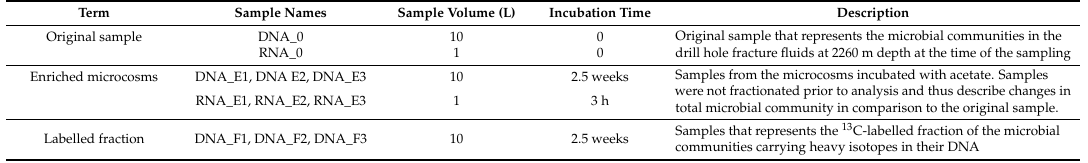
Table 3. The description of the terms and sample names used in text or